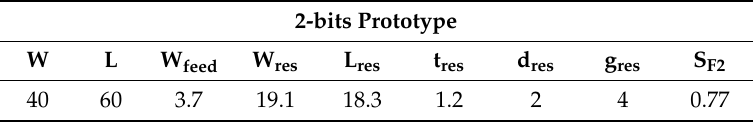
Figure 8. Experimental results achieved for a 2-bit prototype: ( a ) 2-bit prototype under test; ( b ) |S 21 | corresponding to all possible configurations; ( c ) phase of the S 21 corresponding to all the possible configurations. Table 3. Geometrical parameters of the 2-bit prototype shown in Figure